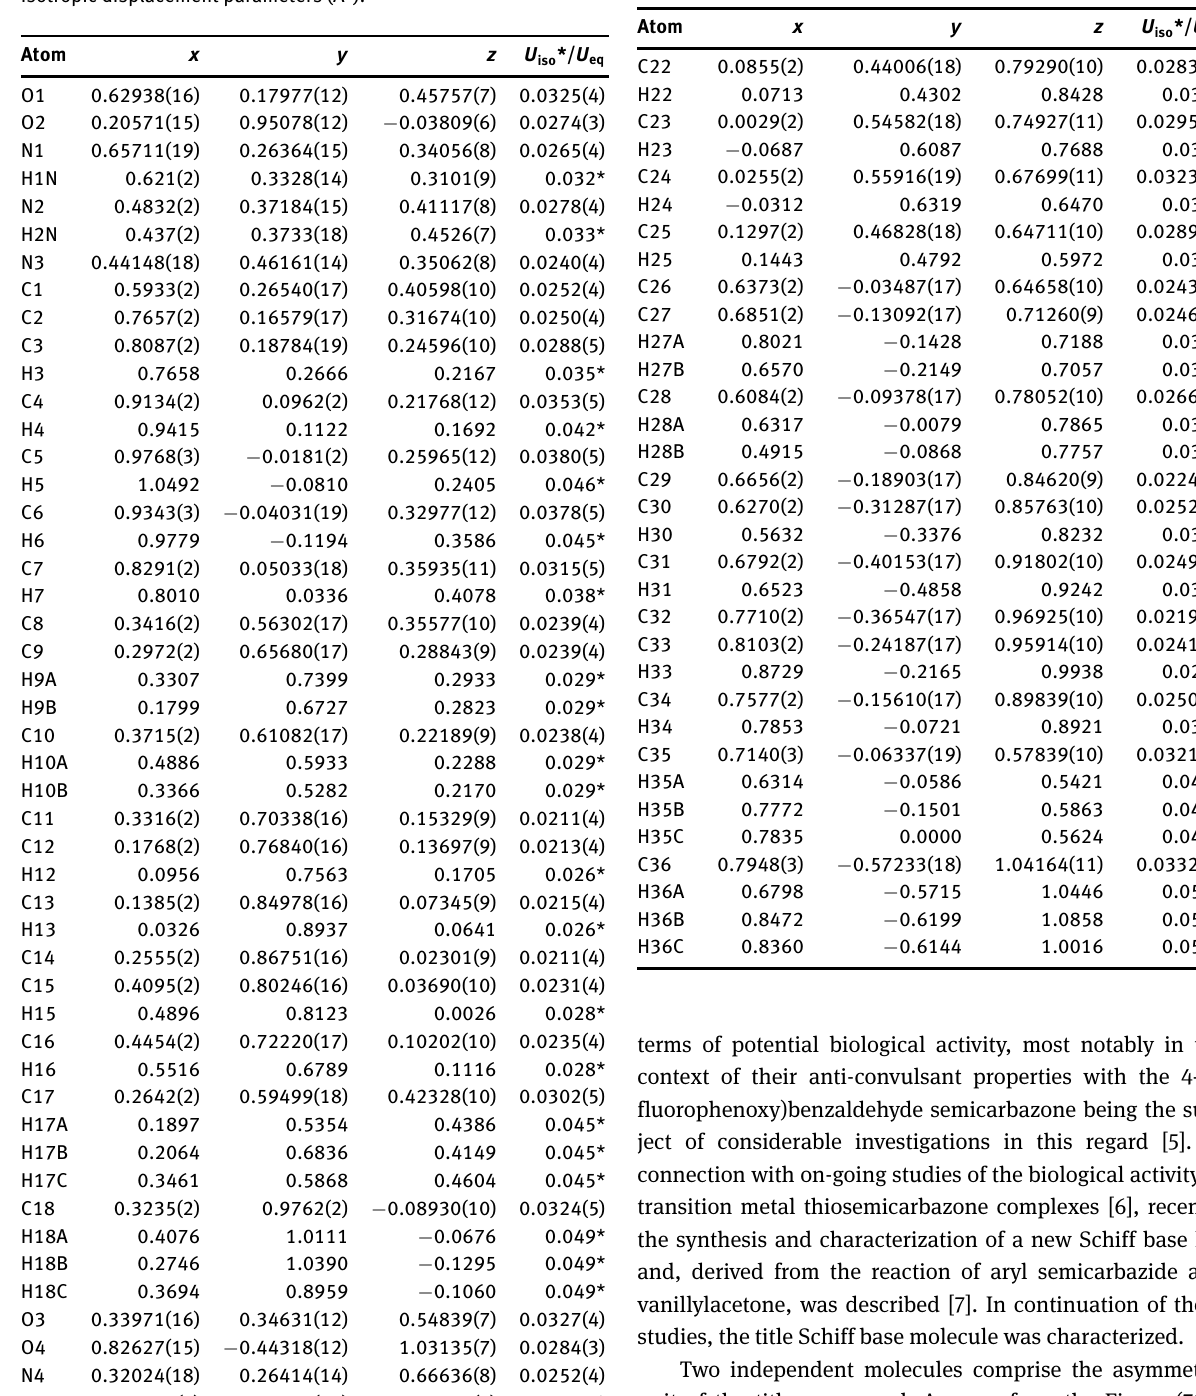
Table 2: Fractional atomic coordinates and isotropic or equivalent isotropic displacement parameters (Å 2